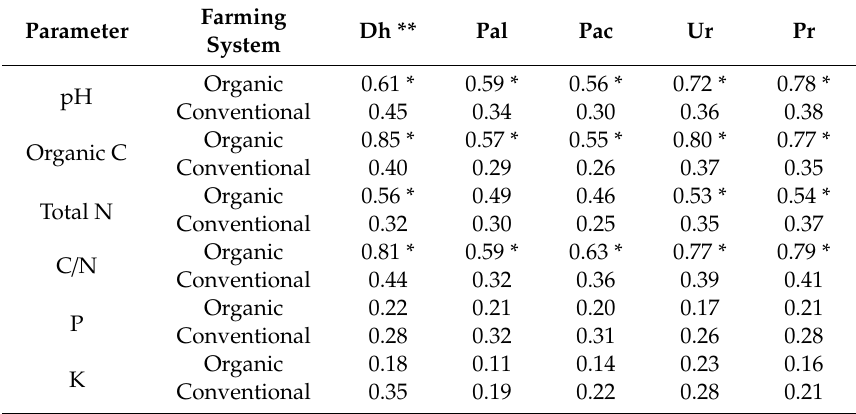
Table 7. Correlation coe ffi cients (r) between selected soil chemical components under organic and conventional systems and enzymatic activity.